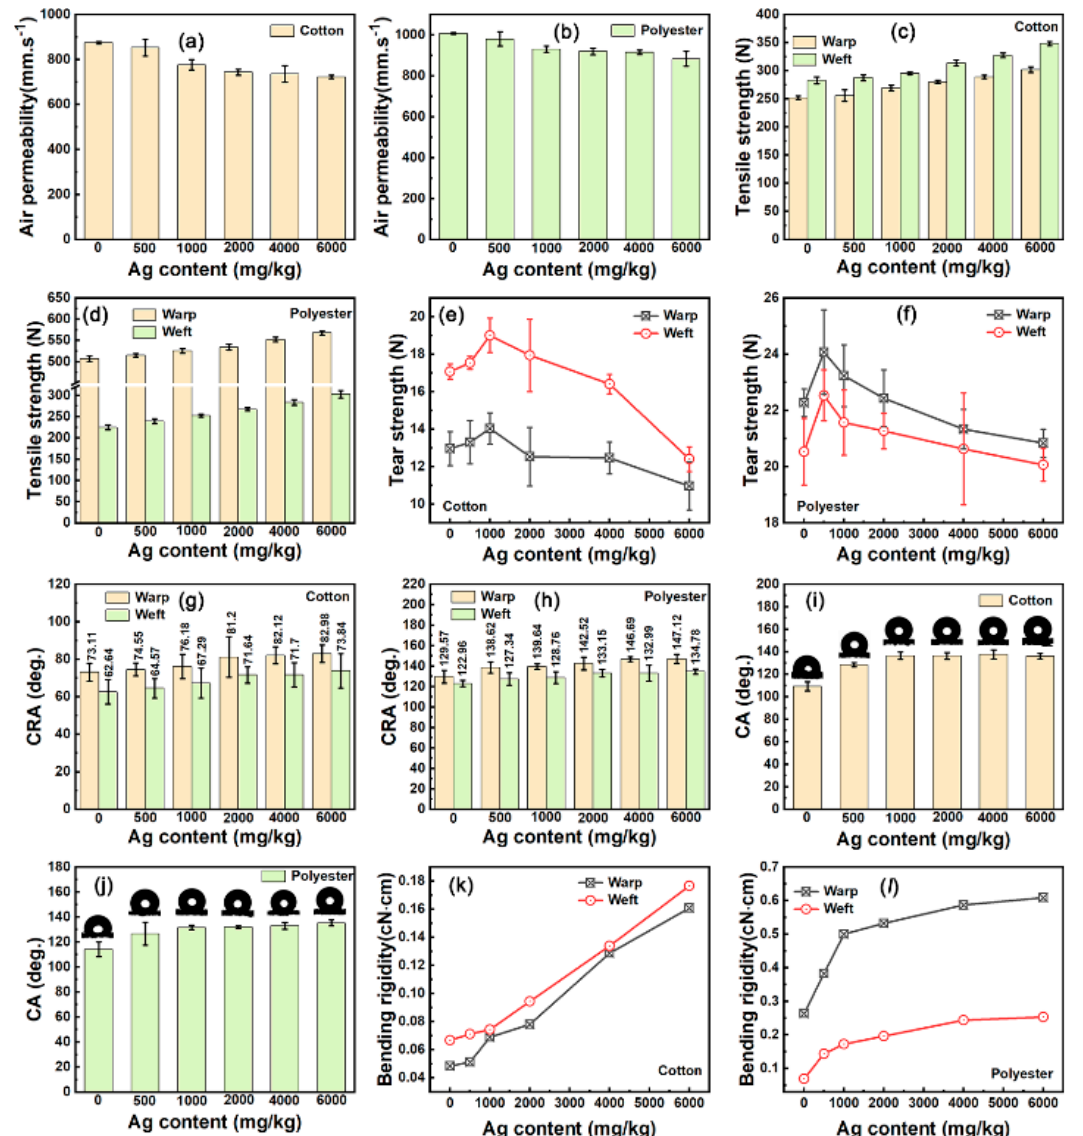
Figure 12. Mechanical properties of nanosilver-glue-coated cotton and polyester fabrics: ( a , b ) air permeability, ( c , d ) tensile strength, ( e , f ) tear strength, ( g , h ) crease recovery angle (CRA), ( i , j ) water contact angle (CA), and ( k , l ) bending rigidity of pure and coated cotton and polyester fabrics.